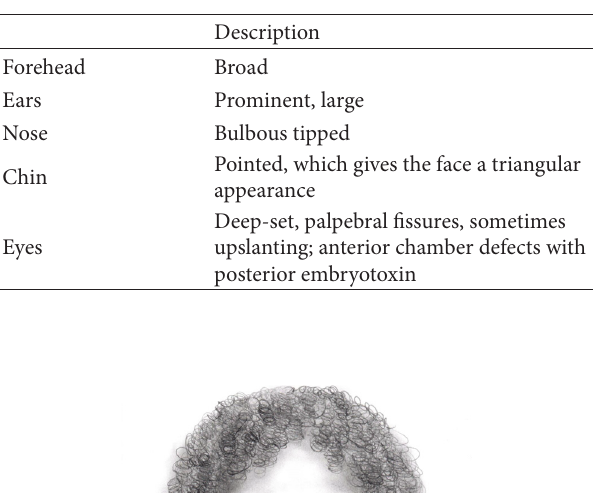
Table 1: Dysmorphic facial features associated with Alagille syn- drome.